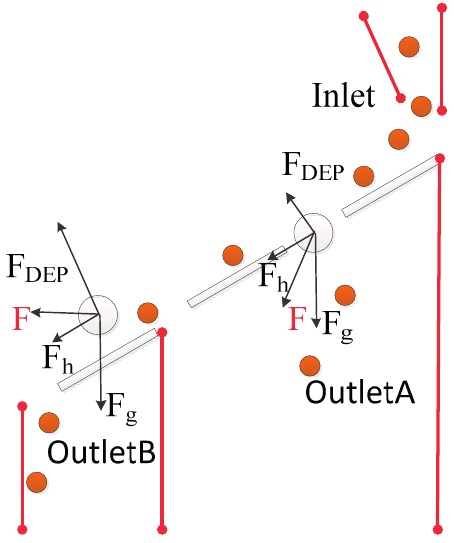
Figure 8. The simulation analyses of forces on